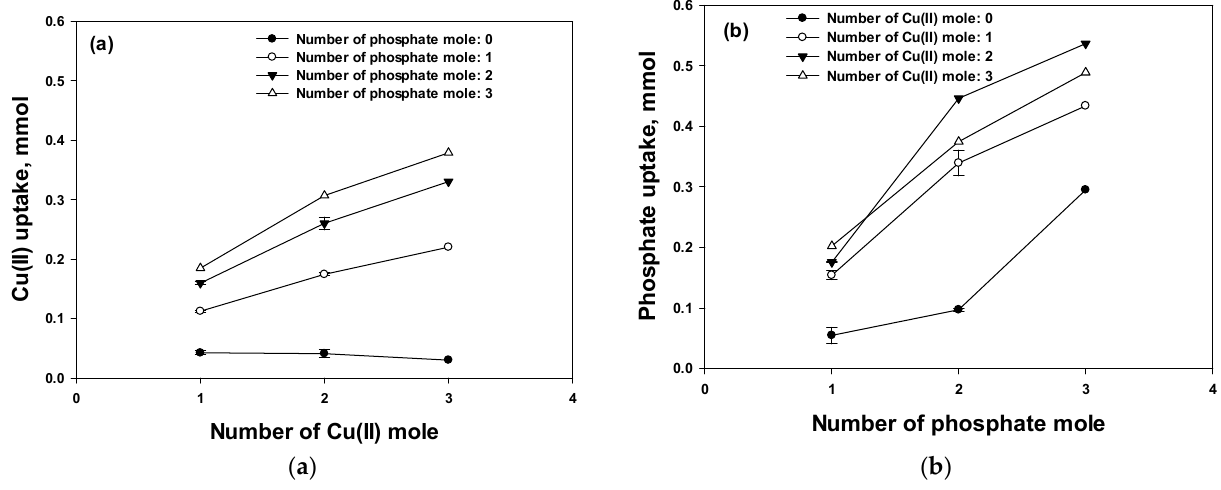
Figure 3. Uptake of Cu(II) ( a ) and phosphate ( b ) at different initial concentrations.